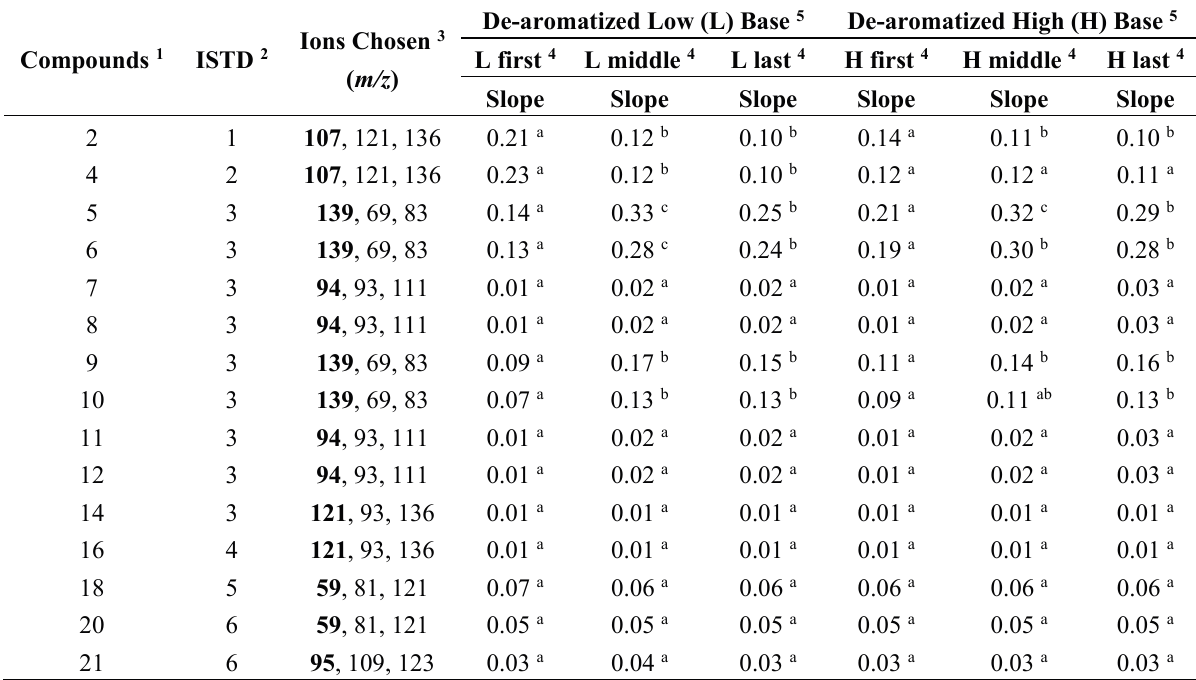
Table 1. Calibration curve information of 15 chiral monoterpenes in different de-aromatized wine